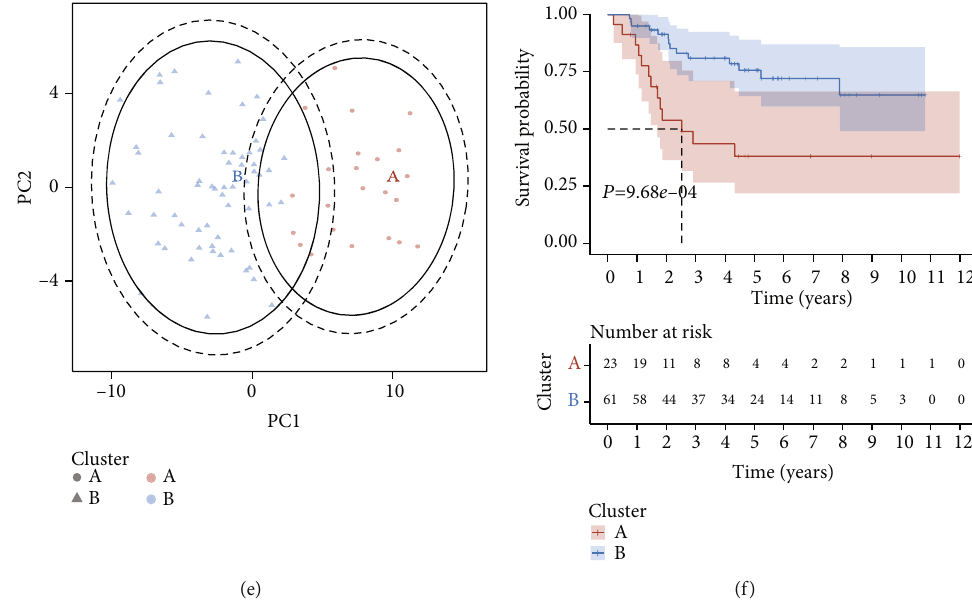
Figure 2: Characterization of two EMT molecular subtypes across osteosarcoma patients in the TARGET cohort. (a) Forest plots depict the univariate cox regression analyses results of EMT genes that were signi fi cantly linked to osteosarcoma prognosis with P < 0 : 05 . Red indicates risk factor while blue represents protective factor. (b) CDF curves when k = 2 to 9. (c) The relative variations of the area under the CDF curves that k from 2 to 9. (d) The consensus clustering matrix at k = 2 . (e) PCA plots visualizing the discrepancy in two clusters in accordance with the expression pro fi ling of prognostic EMT genes. (f) Kaplan-Meier survival analyses for patients in two